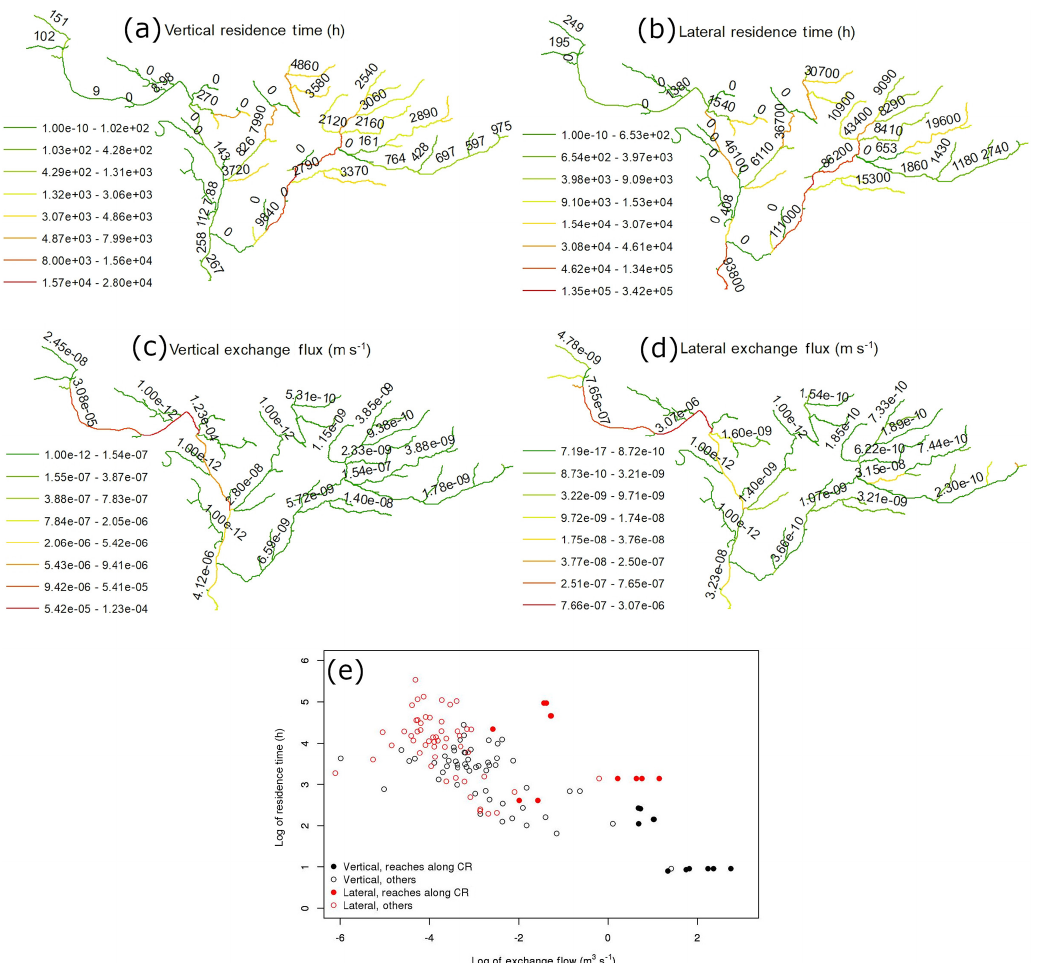
Figure 3. NEXSS simulated vertical (a, c) and lateral (b, d) residence times (h) and exchange flux (ms − 1 ) in the watershed and scatter plot of exchange flow (m 3 s − 1 ) versus residence time (h) (e) . Solid circles in (e) are for reaches along the Columbia